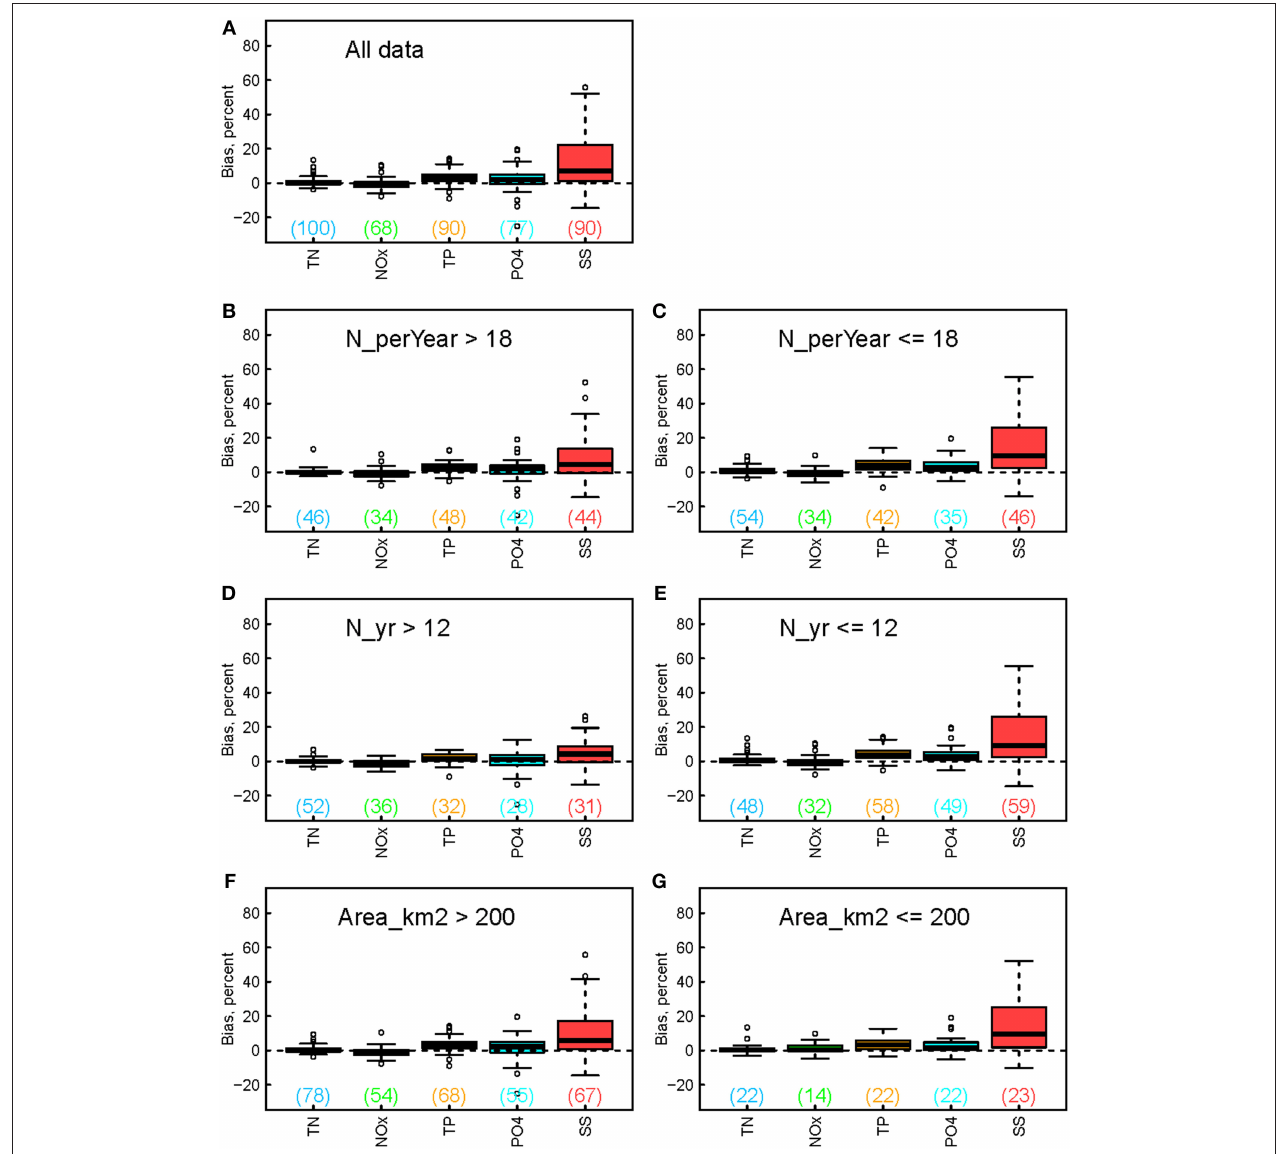
FIGURE 3 | Boxplots showing the estimation bias for constituent concentration for (A) all data and (B-G) their subsets. The subsets correspond to different groups of (B,C) sampling frequency, (D,E) sampling record length, and (F,G) watershed size. Numbers in the brackets indicate numbers of applicable sites for each